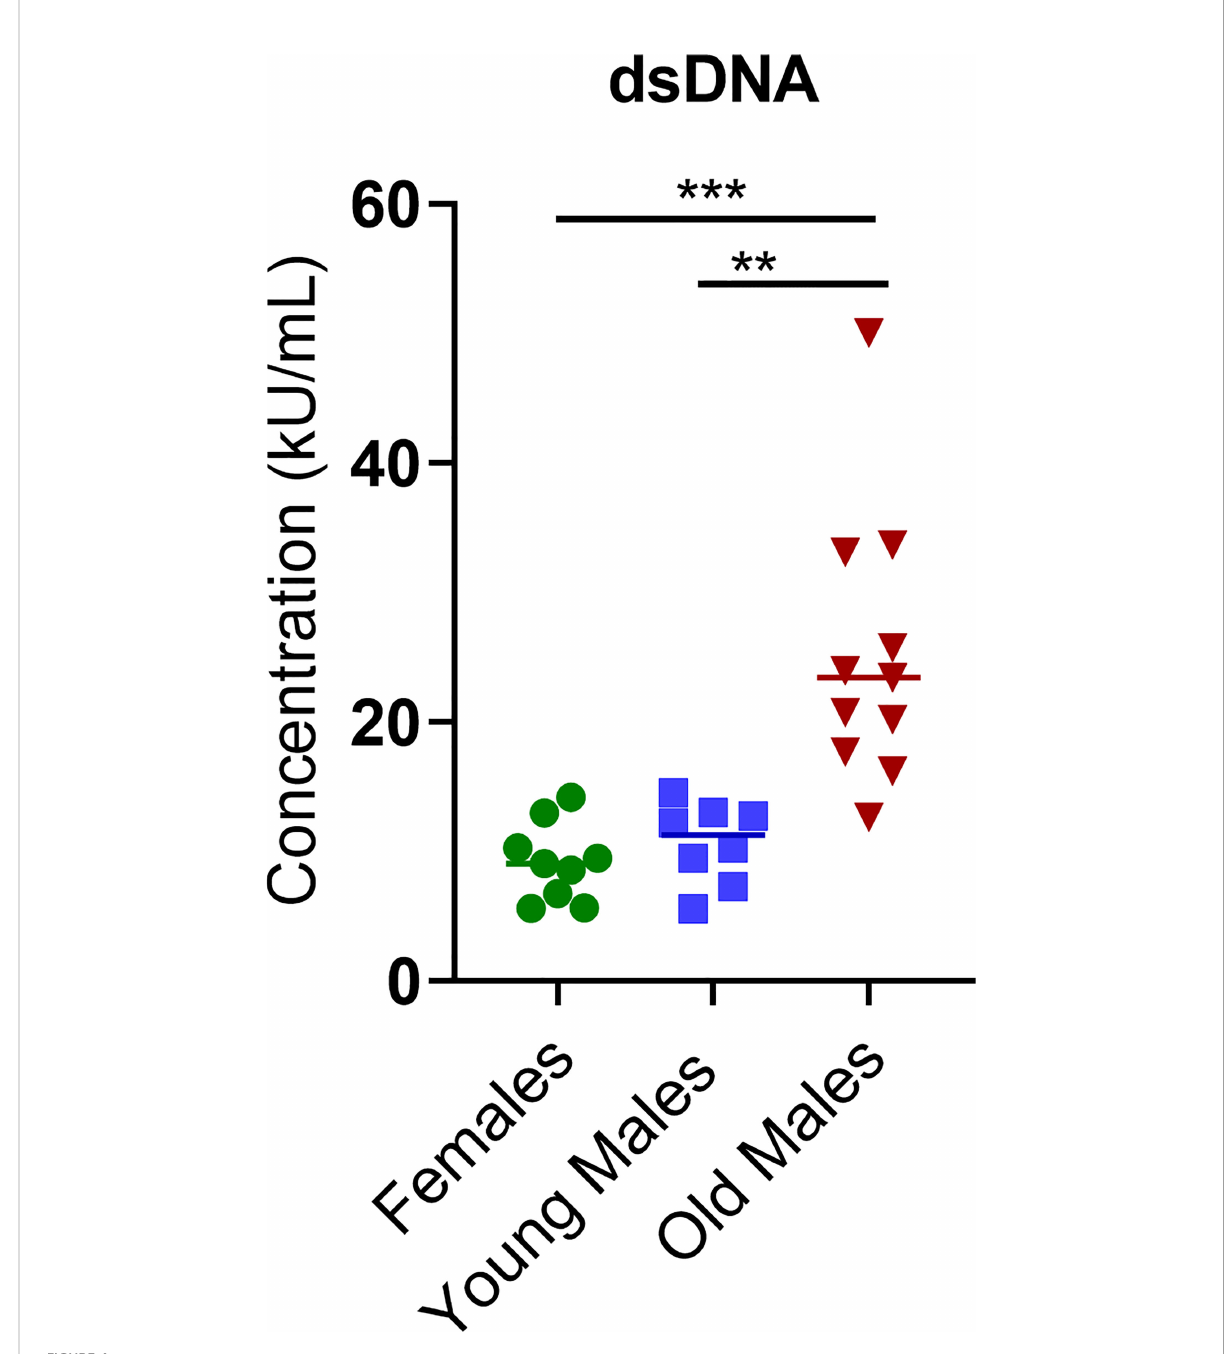
FIGURE 4 Concentration (kU/mL) of anti-double-stranded DNA antibody (anti-dsDNA) was measured in female (green circle dots, n = 9), young/healthy male (blue square, n = 8) and old sick male (red tringle, n = 11). Data are presented as scatter dot plot with median line. P < 0.05 were considered statistically signi fi cant. Signi fi cant level (**p < 0.01; ***p < 0.001) in comparison to